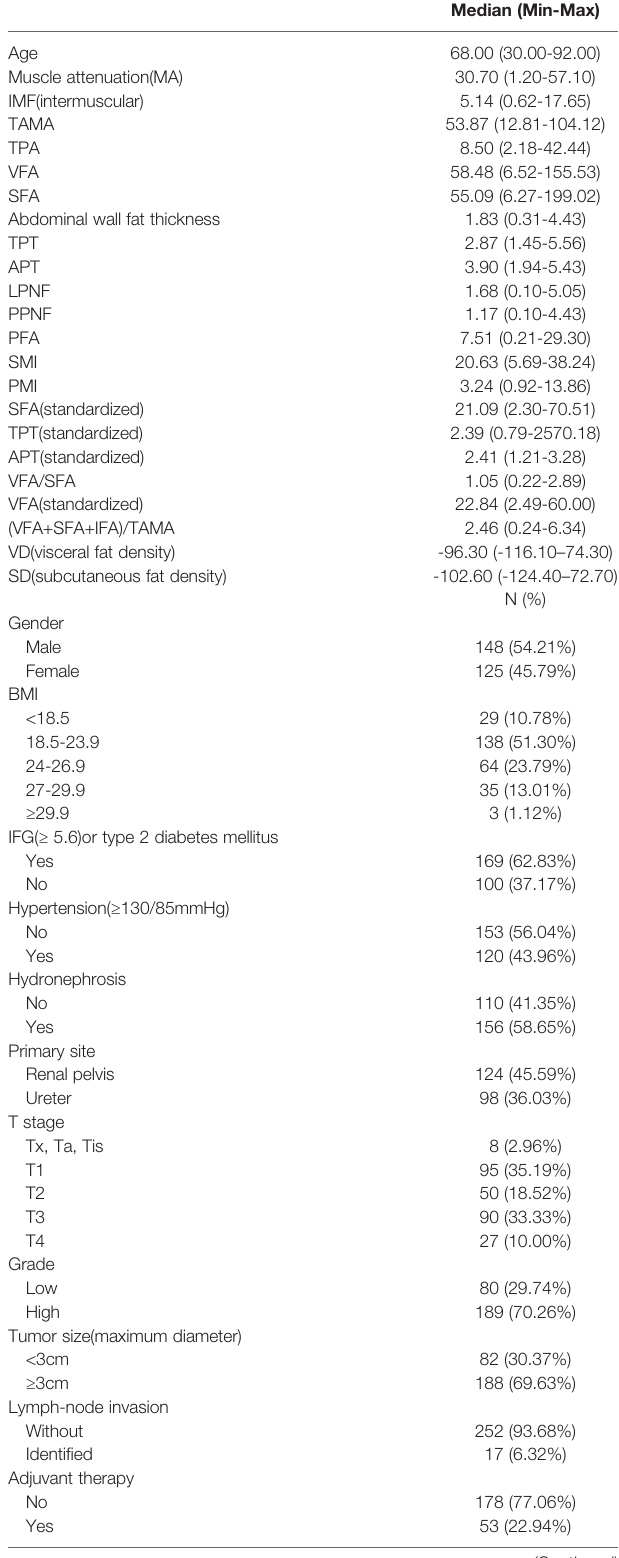
TABLE 1 | Baseline characteristics of study